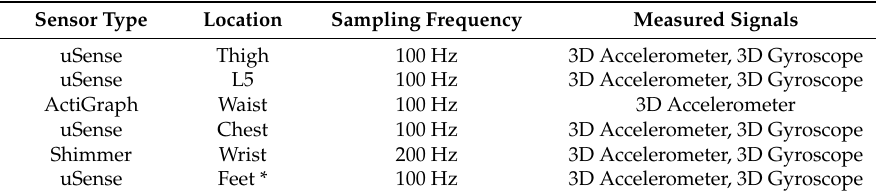
Table 1. Description of the sensors used for data collection.